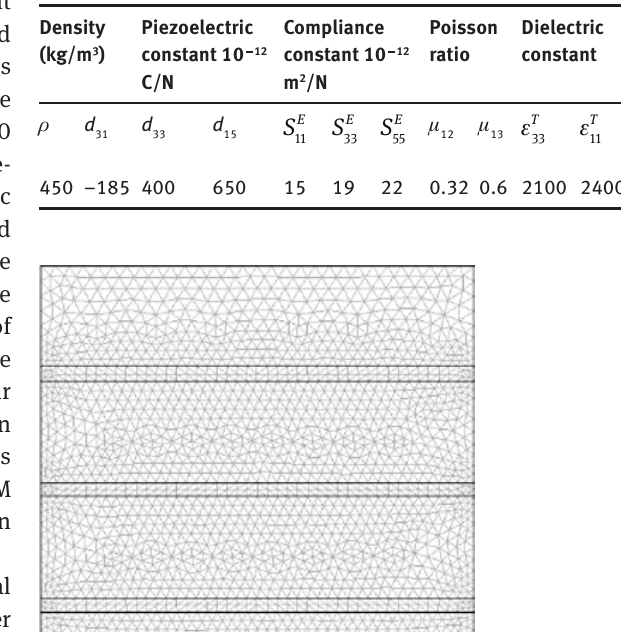
Table 1: The basic material parameter of PZT-51.